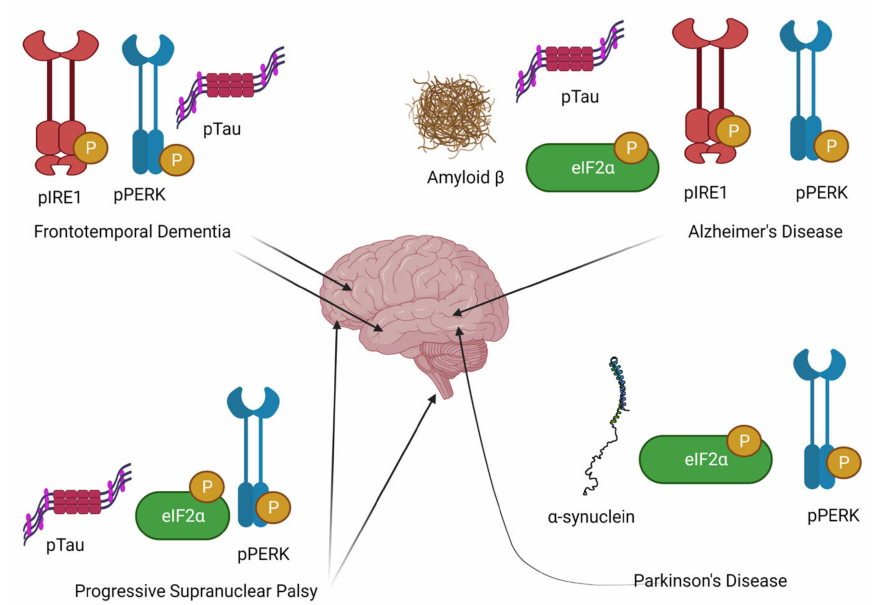
Figure 1. Markers of UPR activation associated with pathological protein deposition in neurodegener- ative disordersProteins associated with UPR activation are seen in association with protein aggregates in specific brain regions in patients with different neurodegenerative diseases. Inositol-requiring enzyme 1 (IRE1) and protein kinase RNA-like endoplasmic reticulum kinase (PERK) are key sensory proteins for ER stress, and are activated in frontotemporal dementia and Alzheimer’s disease. p-PERK and its downstream substrate eukaryotic initiation factor 2 (eIF2)—p-eIF2 α —are also activated in Parkinson’s disease, Alzheimer’s disease, and progressive supranuclear palsy. For a review, see Hetz and Saxena (2017)